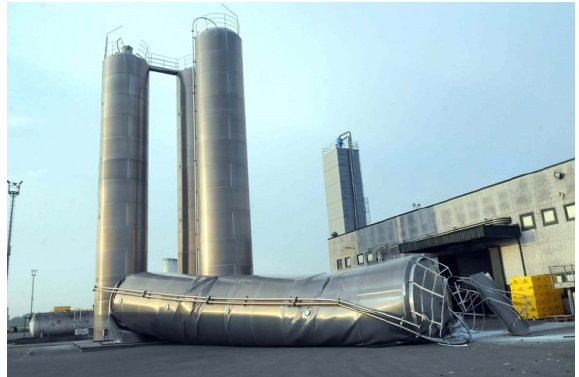
Figure 4. Collapse of steel silo due to